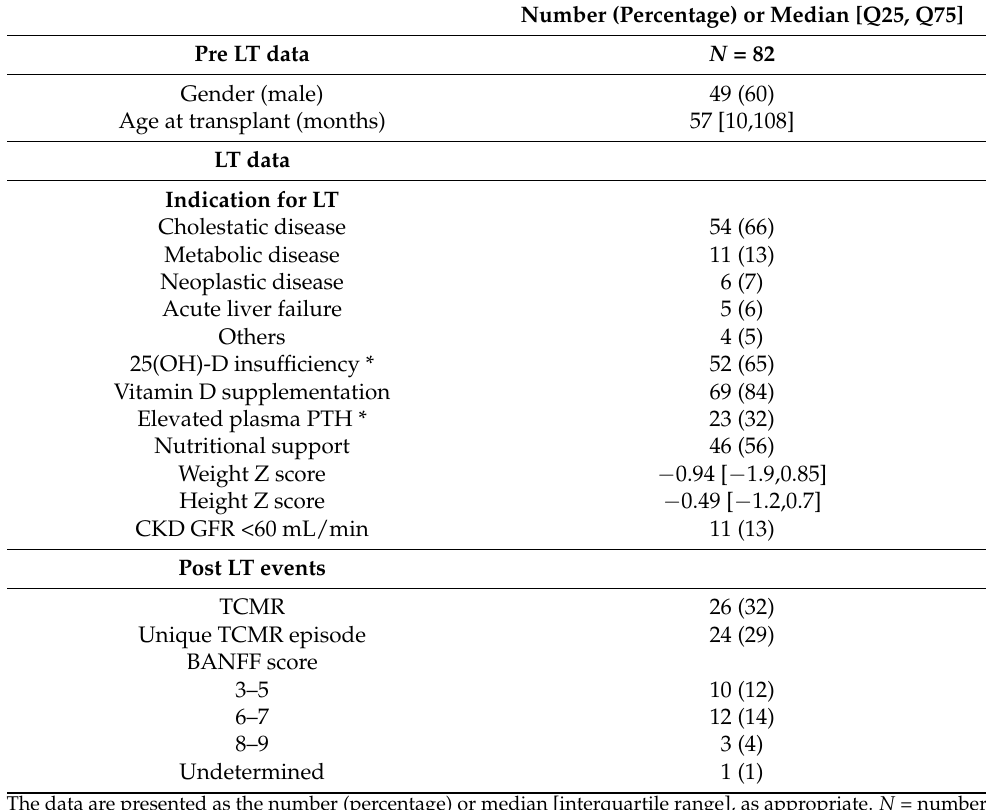
Table 1. Demographics, baseline characteristics, pre-transplant, transplant and post-transplant